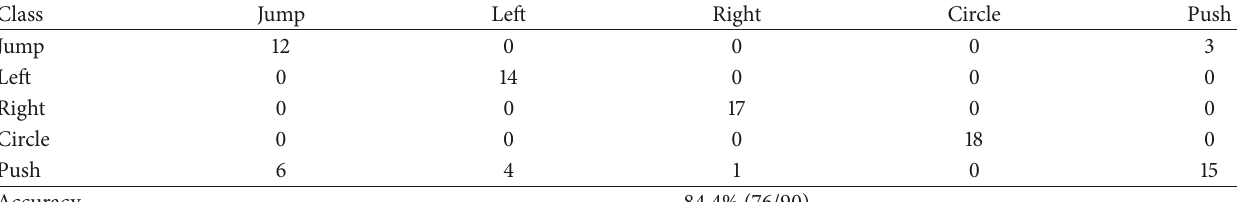
Table 5: Recognition result of testing trajectories.